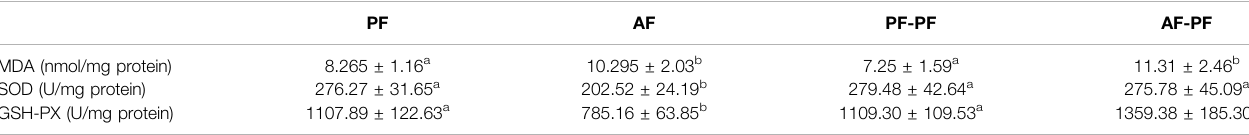
TABLE 2 | Oxidative stress markers level in liver tissue sample after alcohol withdrawal ( n (cid:1) 8).